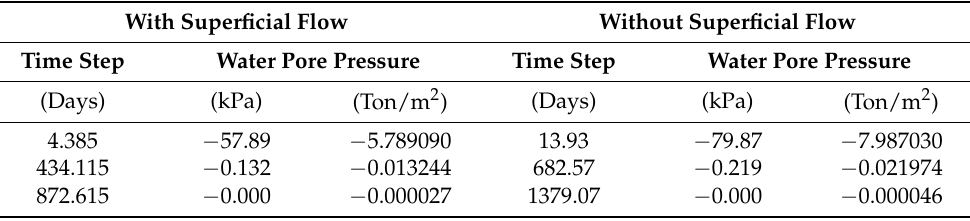
Table 3. Comparative analysis in conditions with and without superficial flow. With Superficial